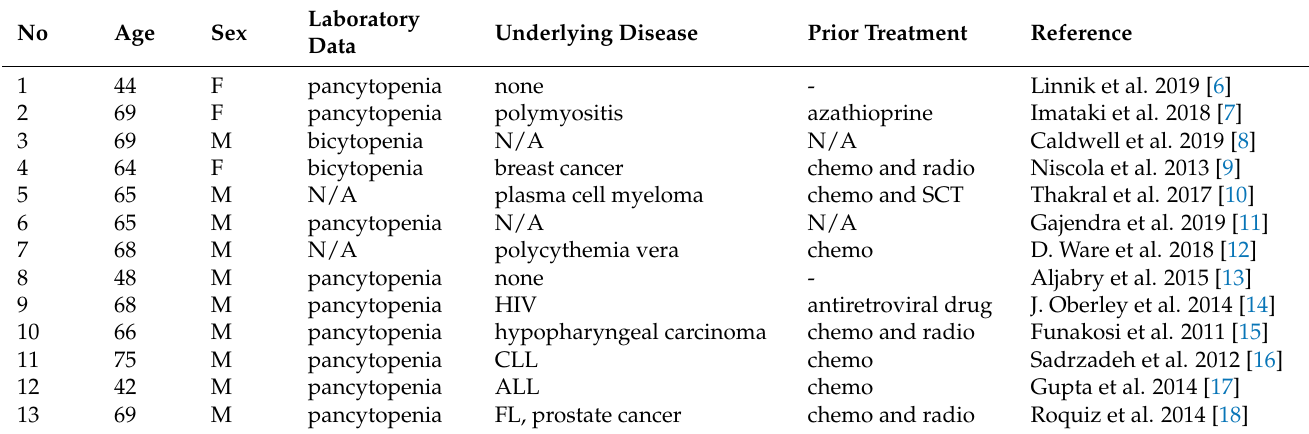
Table 1. Reported case of PEL developed in adults since